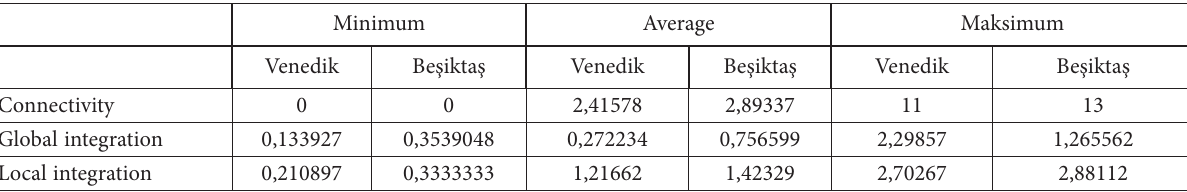
Table 7. Space syntax values of İstanbul and